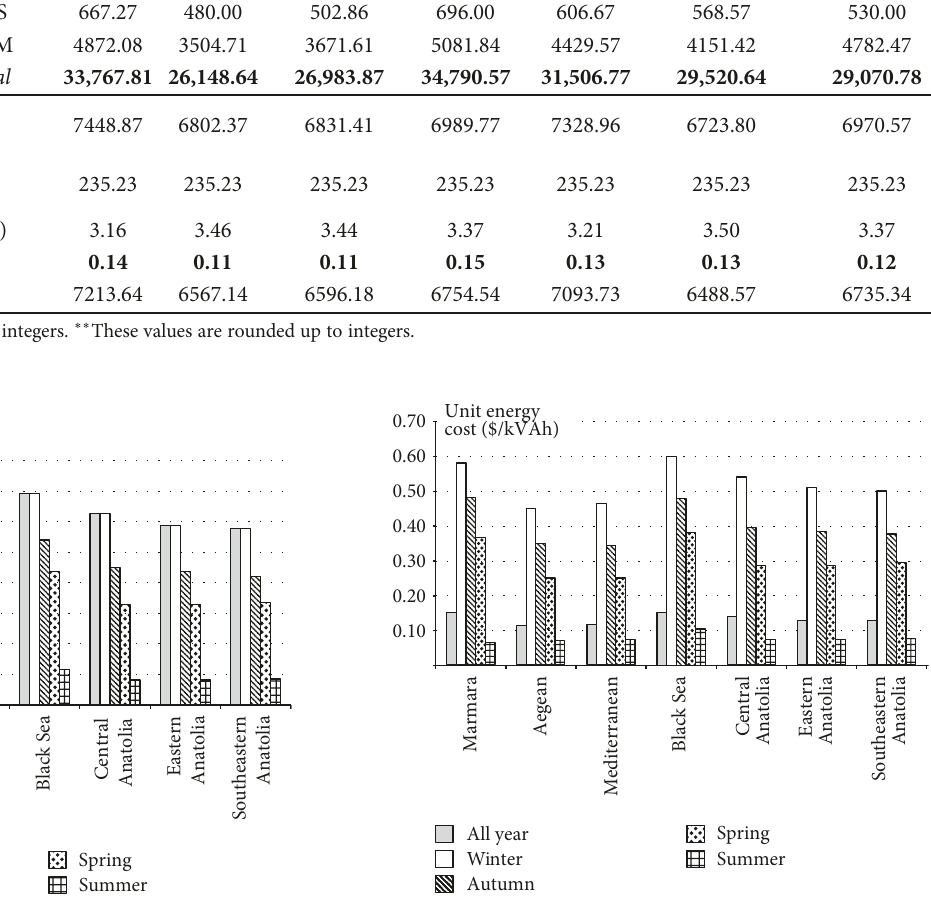
Figure 4: Comparison of unit energy costs by geographical areas and